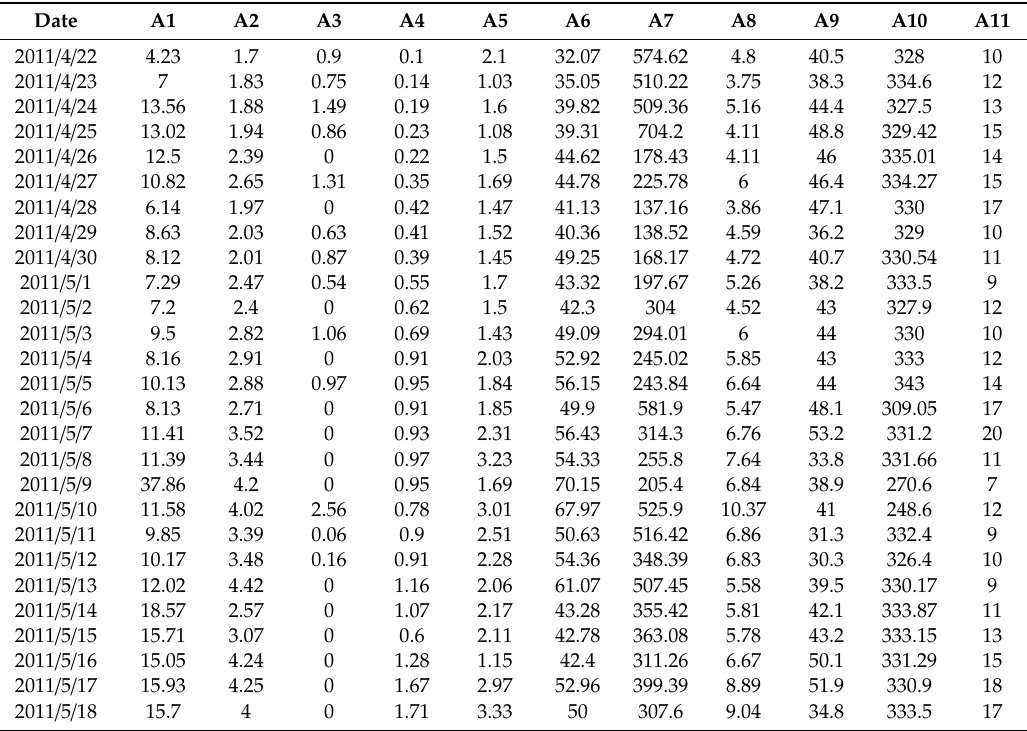
Table 5. Distribution of transformer sample data.